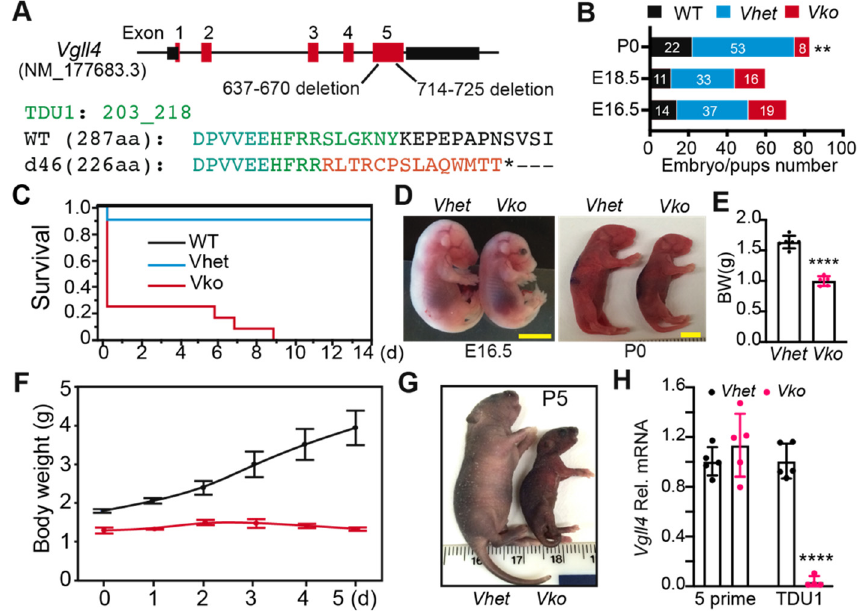
Figure 2. VGLL4 deletion resulted in perinatal lethality: ( A ) Vgll4 gene structure showing Vgll4 - mutant allele. Green and red letters indicate wild-type and d46 mutant amino acid sequences, respectively; * indicates a premature stop codon; ( B ) distribution of genotypes at E16.5, E18.5, and P0. Embryo/pup numbers for each genotype are displayed in the bar graph. **, Mendelian ratio chi-squared test , p < 0.01; ( C ) survival curve of Vgll4 d46/+ ( Vhet ) and Vgll4 d46/d46 ( Vko ) pups. Postnatal day 0 (P0) was designated as the date of delivery. For each group, n = 12; ( D ) gross morphology of embryos and mouse pups at indicated ages. Scale bar: 5 mm; ( E ) body weight at E18.5; ( F ) mouse pups’ body weight gain in the first 5 days after delivery. N = 3; ( G ) gross morphology of mouse pups at P5; ( H ) cardiac Vgll4 mRNA expression. E13.5 hearts were collected for mRNA isolation and qRT-PCR measurement. TDU1 domain of Vgll4 was not detectable in the Vgll4 mutant transcripts.